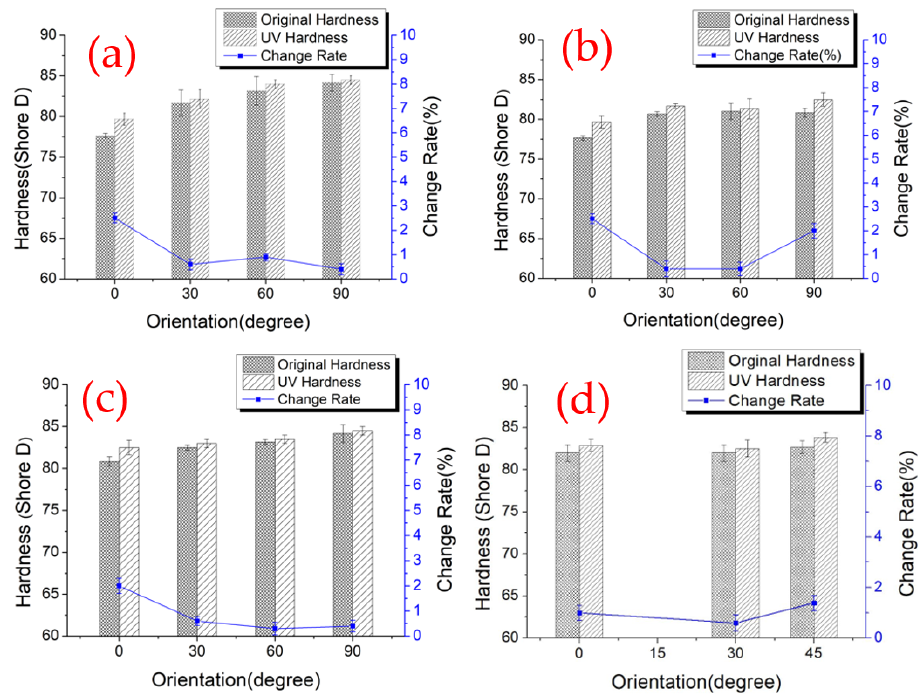
Figure 4. The hardness measurements of the side surface: ( a ) X-type; ( b ) Y-type; ( c ) Z-type; ( d ) R-type.